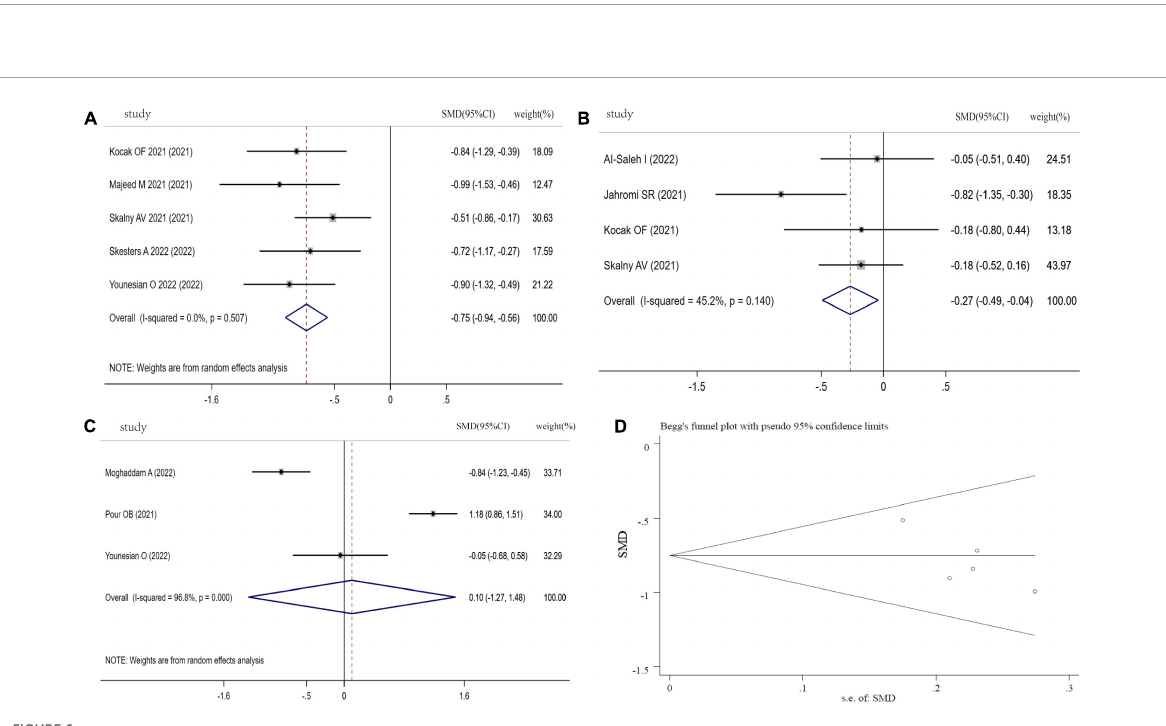
FIGURE6 Forest plot of Se levels. (A) Se levels between COVID-19 patients and controls; (B) Se levels between severity status and non-severity status in COVID-19 patients; (C) Se levels between non-survivors and survivors in COVID-19 patients; (D) funnel plot of the meta-analysis on Se levels between COVID-19 patients and